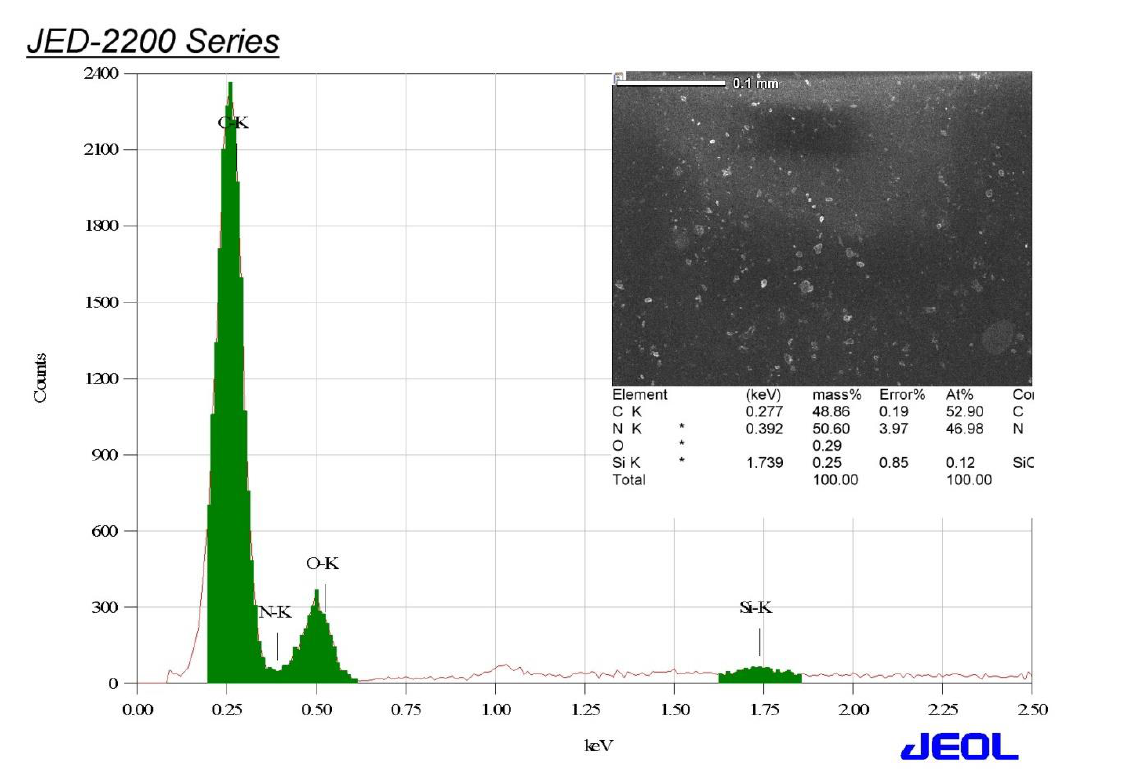
Figure 7: SEM-EDX of PUDCEA-2 Figure 7. SEM-EDX of PUDCEA-2 nanocomposite